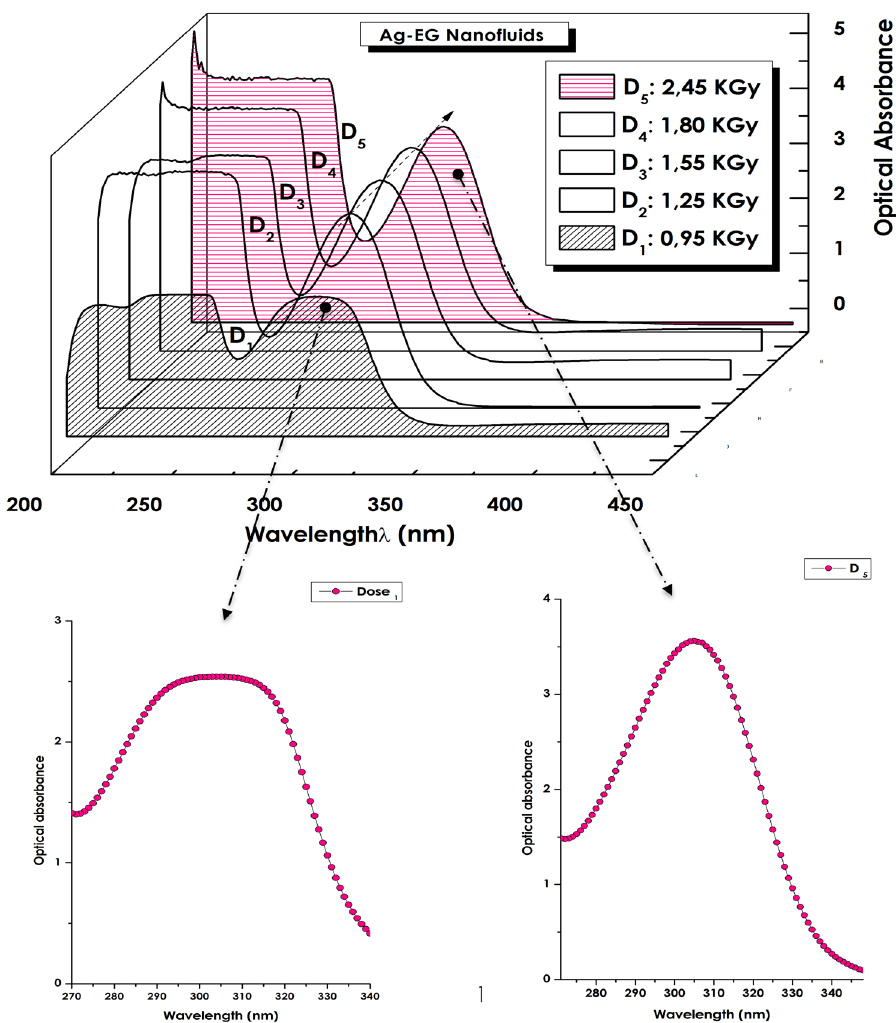
Figure 6. UV–VIS-NIR absorbance of the various Ag-C 2 H 6 O 2 nanofluids radiolized at D 1 = 0.9510 3 , D 2 = 1.25 × 10 3 , D 3 = 1.54 × 10 3 , D 4 = 1.8010 3 and D 5 = 2.45 × 10 3